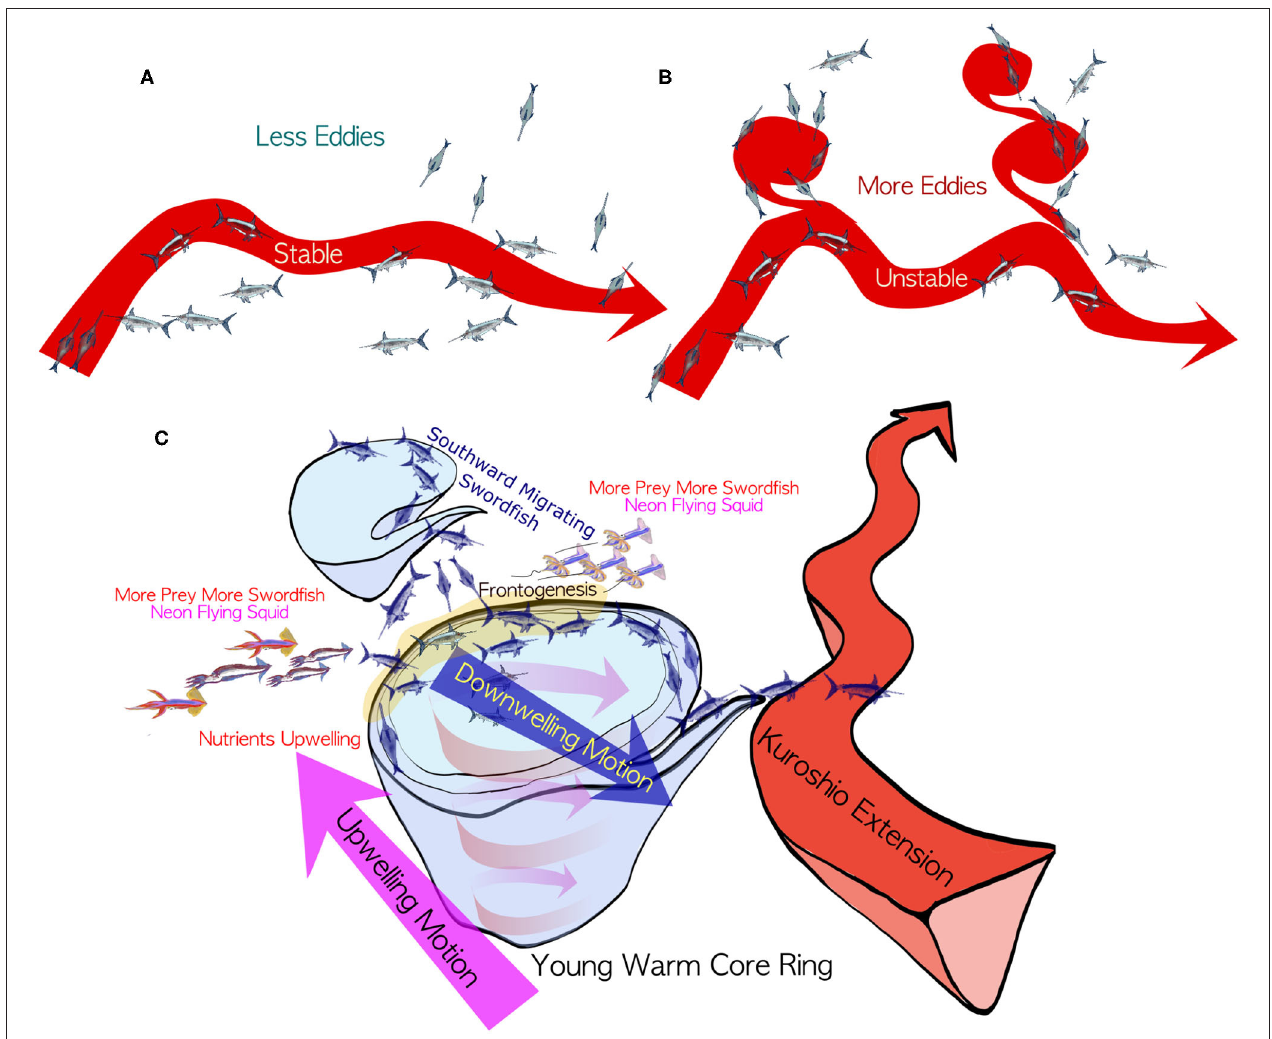
FIGURE 14 | Summary of this study. Schematics for the modulations of the swordfish distributions associated with the Kuroshio Extension path states for (A) stable period in which Kuroshio Extension takes relatively straight path without many warm-core rings and with less northward spreading of swordfish population and for (B) unstable period in which the Kuroshio Extension path exhibits meandering with more warm-core eddies and more swordfish are caught on their northeastern side during southward swordfish migration. The latter (B) unstable period can be characterized by the higher and lower swordfish CPUE in the northern and the southern regions, respectively. The situation reverses during (A) stable period with the lower and higher swordfish CPUE in the northern and the southern regions, respectively. (C) Hypothesis to form high swordfish CPUE on the northeastern side of an anticyclonic warm-core ring. During their southward migration in autumn to winter, they can encounter their favorable warm-salty environment on the north side of the warm-core eddies. Following the flow of the eddies they might be able to migrate south efficiently with the southward flow on the eastern side of the warm-core eddies. When they reach just north of the Kuroshio Extension, they might be attracted by